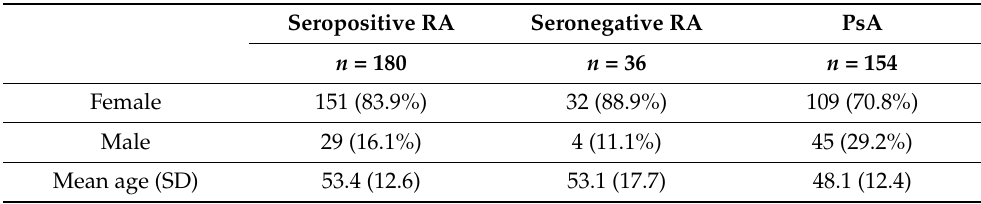
Table 1. Demographic data of patients with seropositive rheumatoid arthritis (RA), seronegative RA, and psoriatic arthritis (PsA): sex and mean age at the acquisition of the